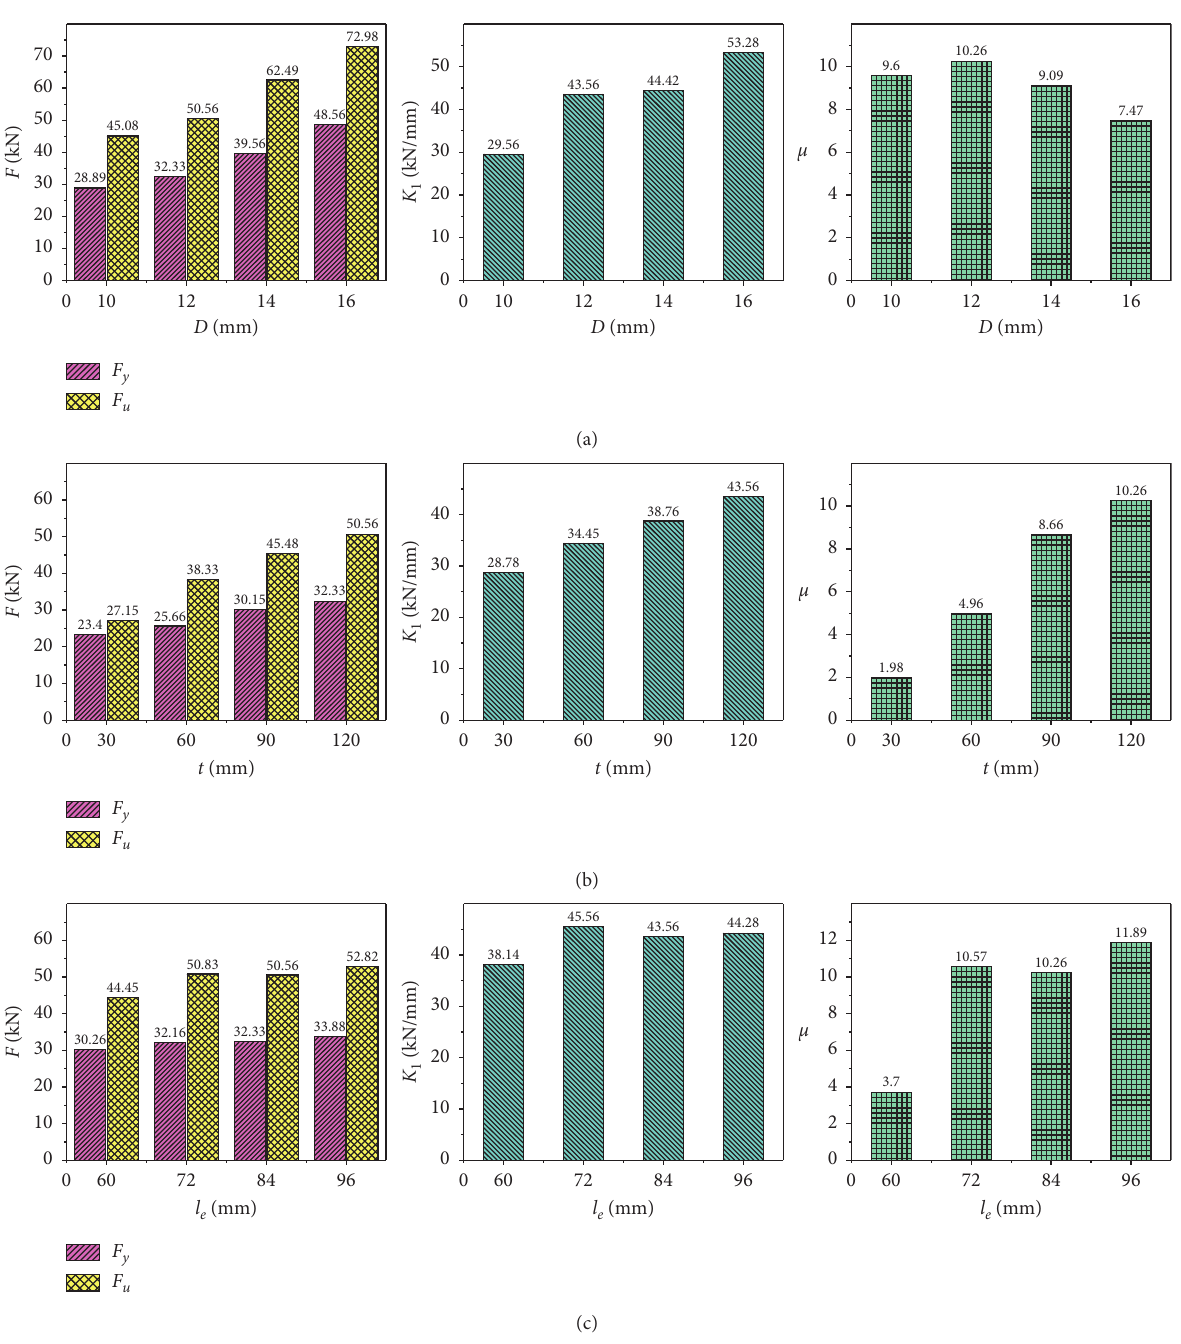
Figure 5: The effect of different factors on the mechanical parameters of the connections. (a) Dowel diameter. (b) The thickness. (c) End